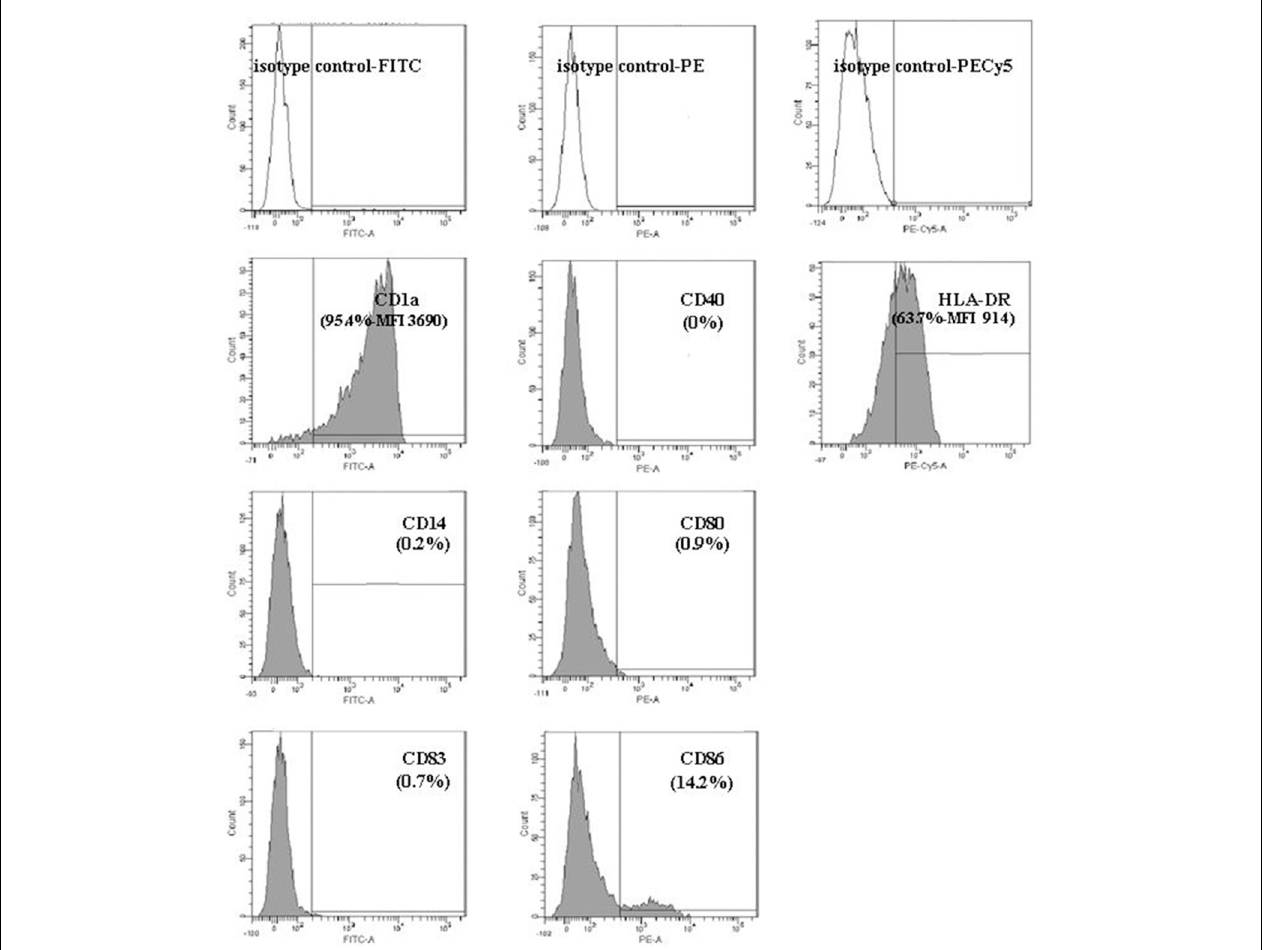
FIGURE A1 | Characterization of the immature state of dendritic cells after 7 days of differentiation with GM-CSF and IL-4 as determined by flow cytometry. After 7 days of culture in the presence of GM-CSF and IL-4, DCs were labeled with the following antibodies: CD14-FITC, CD1a-FITC, CD40-PE, CD80-PE, CD83-FITC, CD86-PE, and HLA-DR-PECy5. They were analyzed by flow cytometry using a Canto II cytometer (Becton Dickinson, Le Pont de Claix, France). The percentages of positively labeled cells were